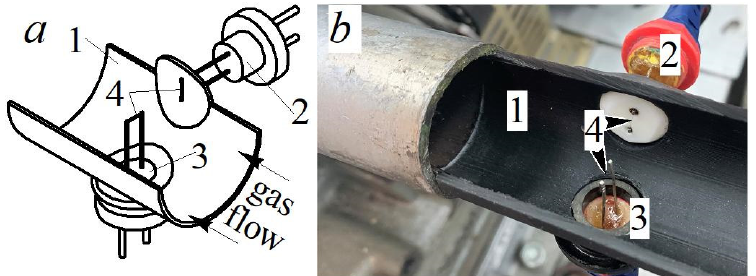
Figure 14. General view ( a ) and photograph ( b ) of the control section for determining local friction stress on the surface: 1—pipeline; 2—hot-wire anemometer sensor for determining local friction stress on the surface; 3—hot-wire anemometer sensor for determining the local gas flow velocity; 4—sensitive element of sensors.